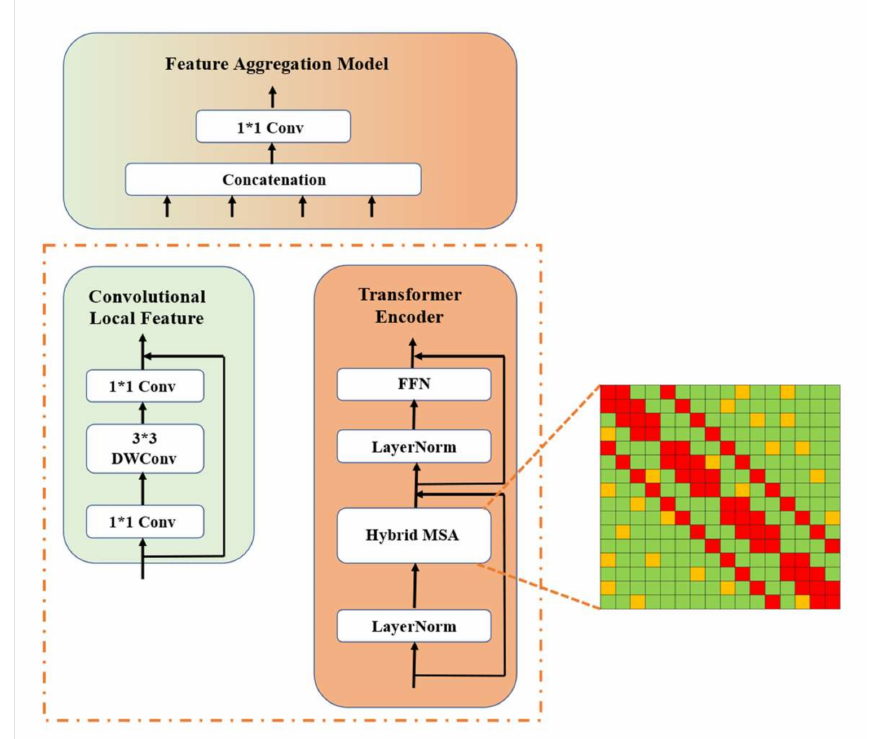
Figure 4. Illustration of the designed Muti-Branch Transformer